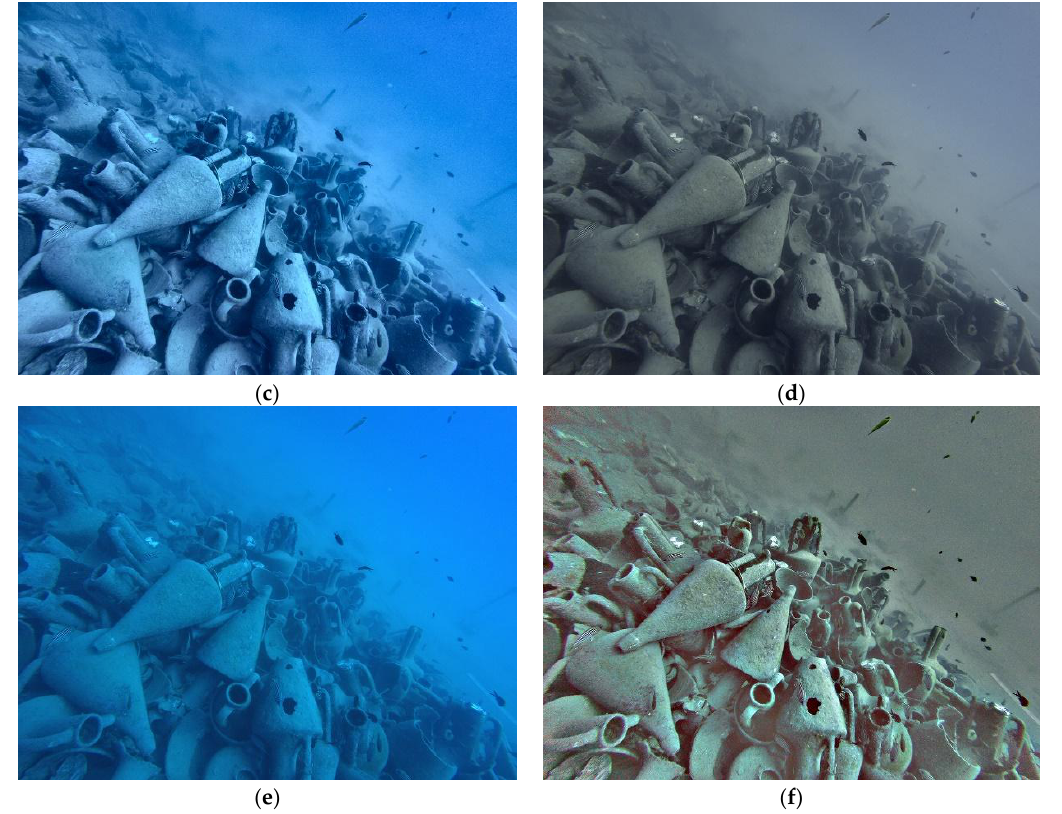
Figure 2. The image “MazotosN4” enhanced with all five algorithms. ( a ) Original image; ( b ) Enhanced with ACE; ( c ) Enhanced with CLAHE; ( d ) Enhanced with LAB; ( e ) Enhanced with NLD; ( f ) Enhanced with SP.